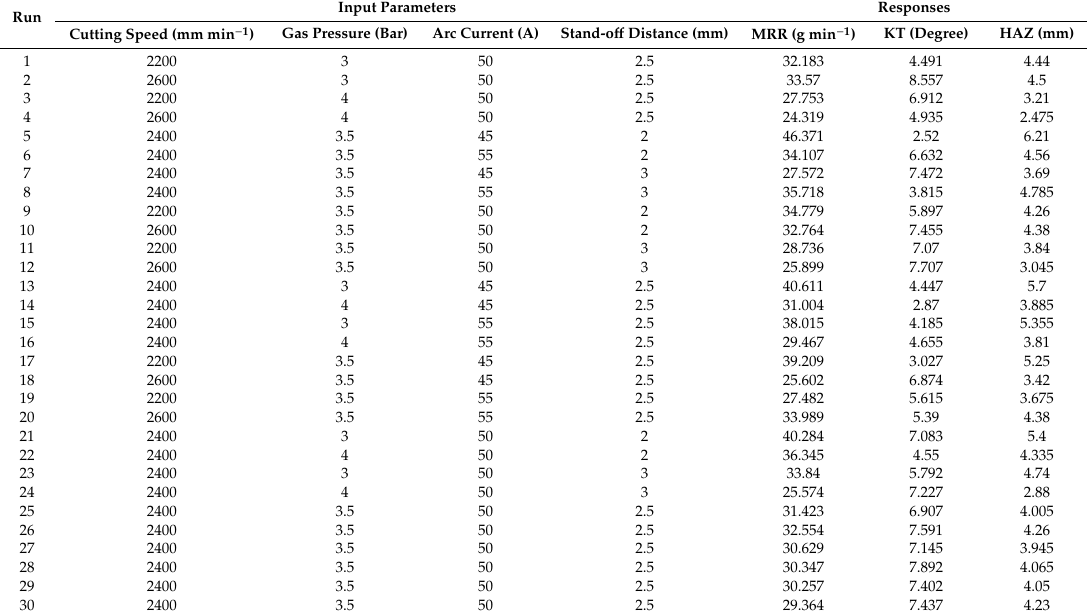
Table 2. Experimental design and measured response